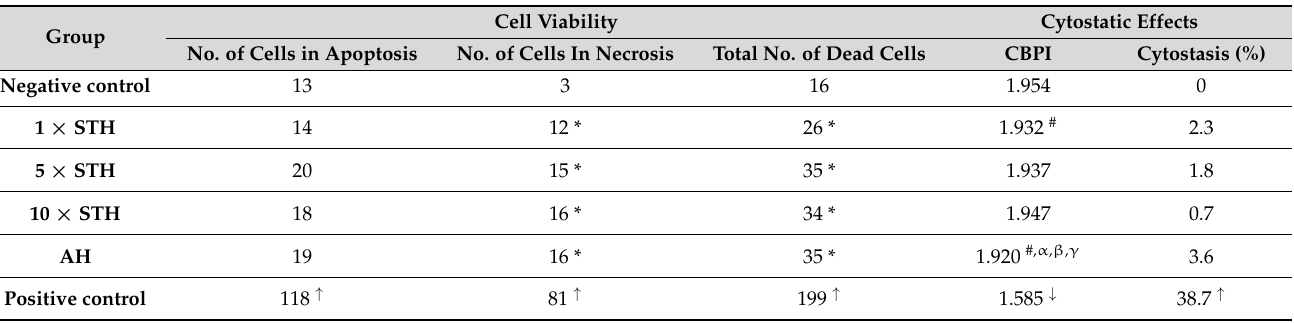
Table 4. Cell viability and cytostatic effects observed after treatment with strawberry tree honey (STH) and artificial honey (AH). Negative control (non-treated cells) and positive control (bleomycin — 15 mg/L) groups were studied in parallel.